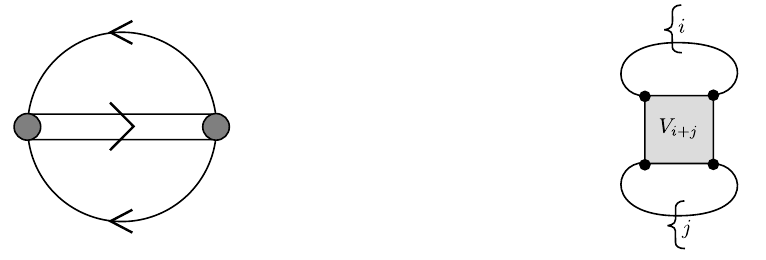
Figure 7. ( Left ) panel: Two-particle irreducible Φ functional describing two-particle correlations (double line with arrow) of elementary fermions (single arrowed lines); ( Right ) panel: Cluster Hartree approximation, following from replacing the two-cluster T matrix in the Φ functional of Figure 5 with the two-cluster potential V i + j